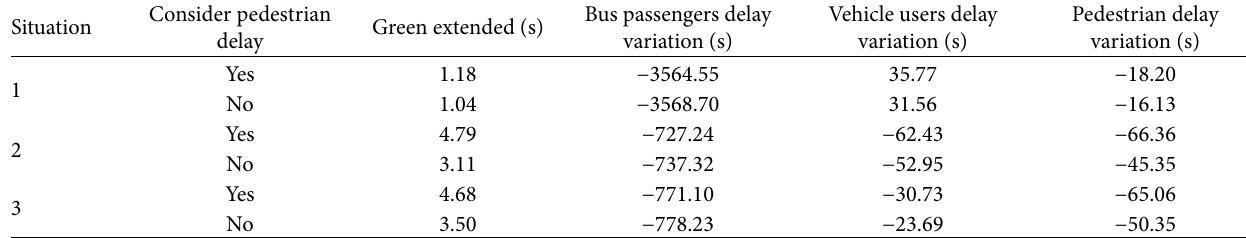
Table 11: Comparison of delay of two control methods during nonpeak